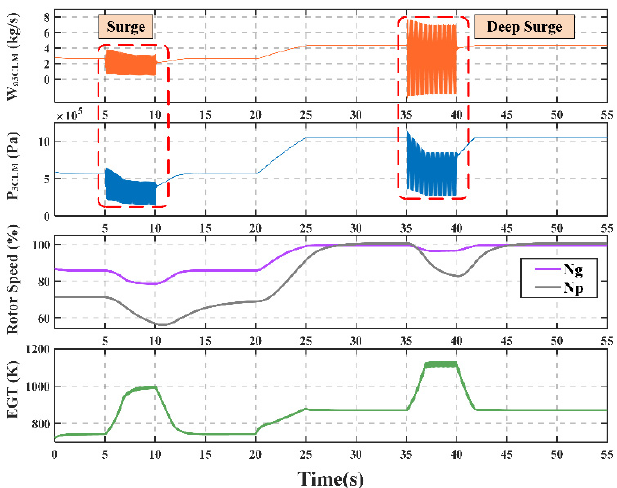
Figure 13. The changes of engine parameters in the surge dynamic process at multiple operating points.